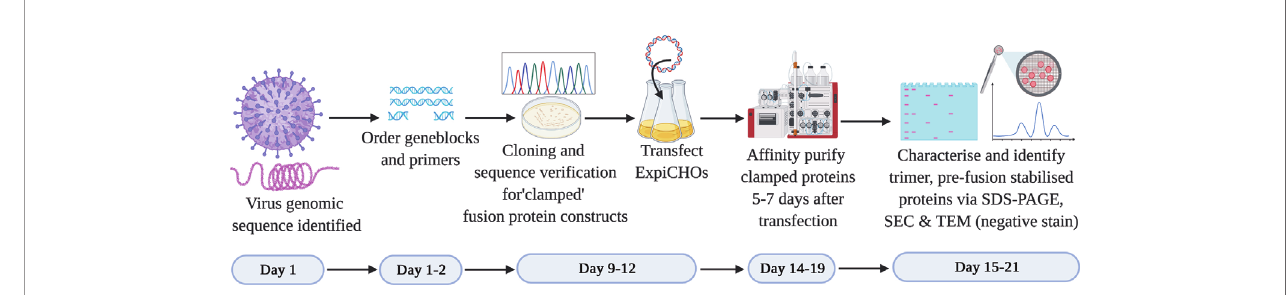
FIGURE 2 | Timeline for the production of subunit vaccine candidates using the Molecular Clamp technology. Day 1 – 2: Following immediate availability of the virus genome sequence information, in silico design of ~20 – 30 constructs are initiated to allow for selection of optimally expressed antigens. The geneblocks and the primers arrive within 4 – 7 days following order placement from IDT after which cloning and transfection of the sequence con fi rmed constructs can be completed within 4 days. Small-scale expression of the transiently transfected cultures is completed within 5 – 7 days prior to af fi nity puri fi cation of the expressed clamped proteins using the culture supernatants. There is no need for pathogen-speci fi c probes for the puri fi cation owing to the availability of human anti-clamp antibody embedded columns in-house. Puri fi ed proteins are analyzed in vitro for the expression yield, protein homogeneity on an SDS-PAGE, and the presence of the desired pre-fusion conformation by SEC and TEM (negative stain). The protein puri fi cation and in vitro analysis can be completed within 1 – 3